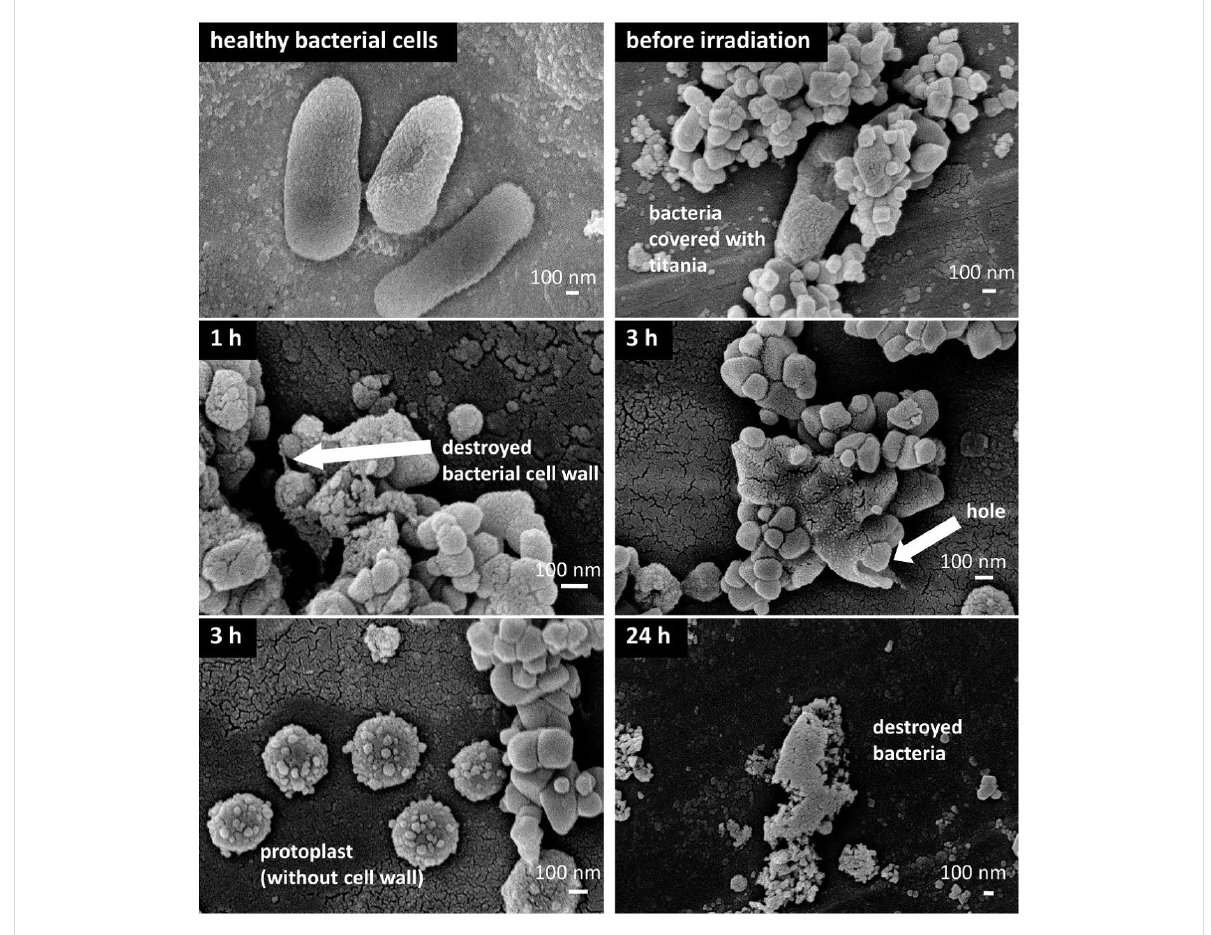
Figure 5: SEM images of the decomposition of bacterial cells under vis ( λ > 420 nm) irradiation on Ag/TiO 2 (ST41) photocatalyst.